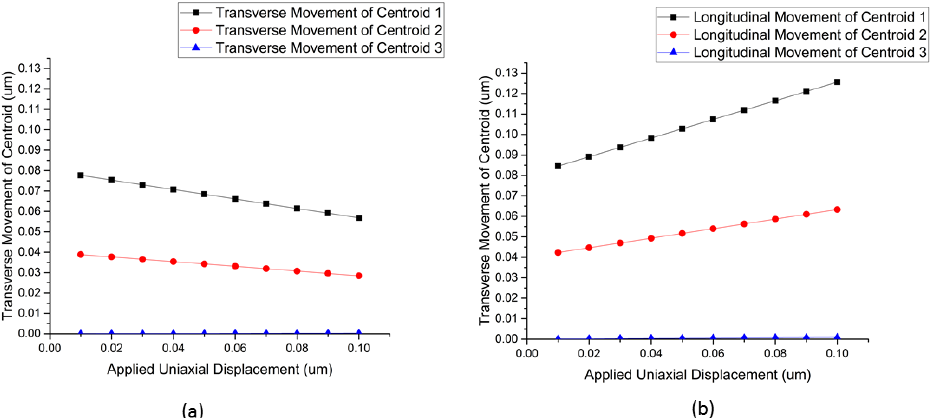
Figure 3. ( a ) Displacement of the centroids of nanoislands 1, 2, and 3 in the transverse direction of a stretch, indicating a reduction in the spacing under an applied strain. ( b ) Displacement of the centroids of nanoislands 1, 2, and 3 in the direction of the strain, indicating an increase in the spacing under an applied strain.